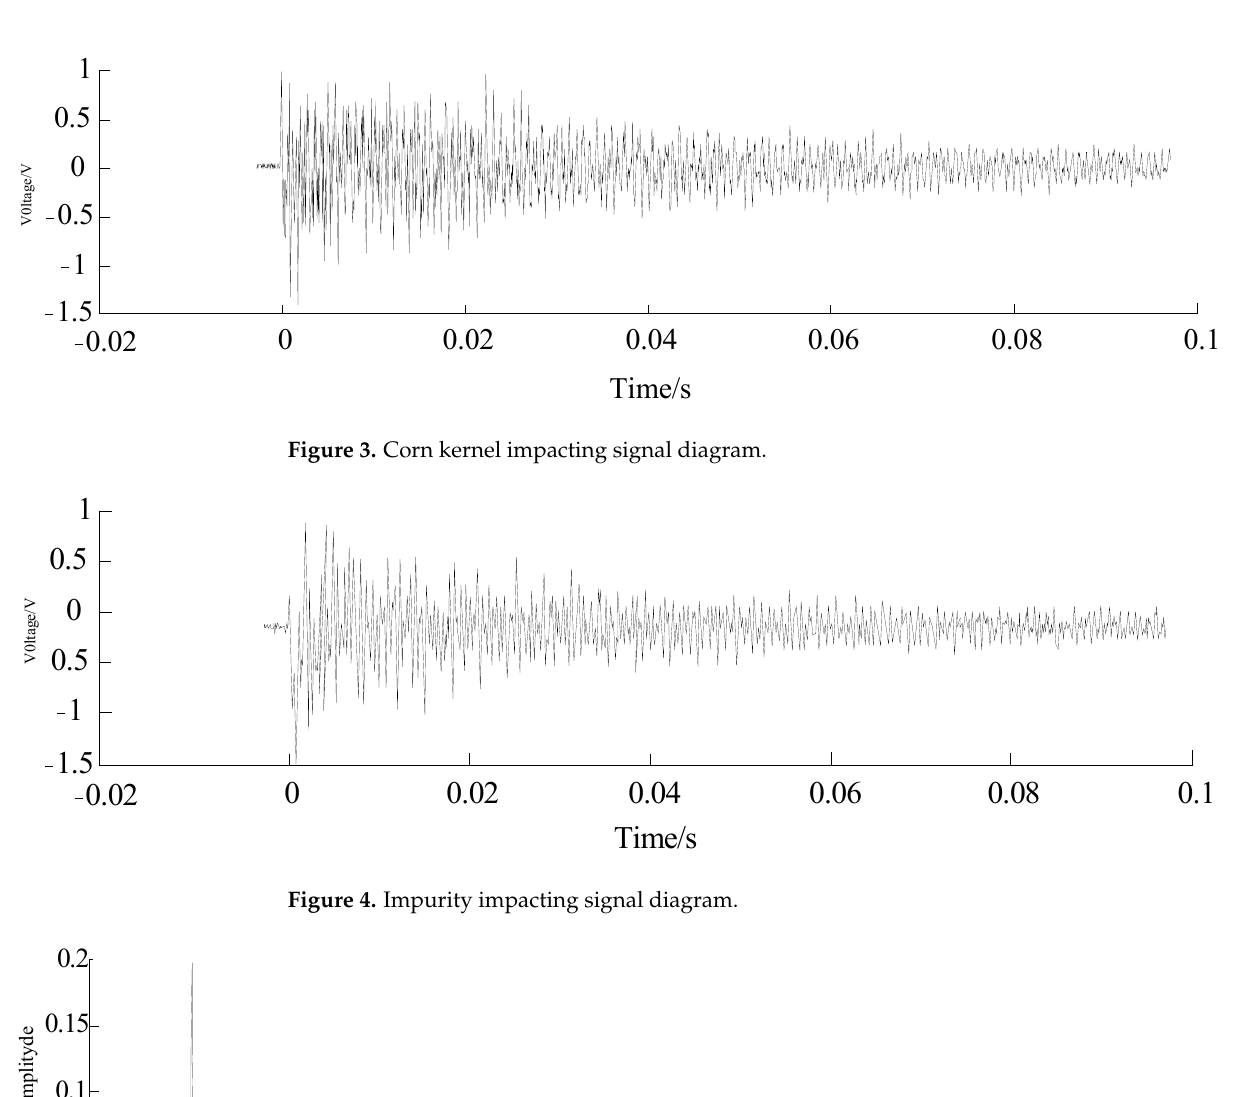
Figure 4. Impurity impacting signal diagram.